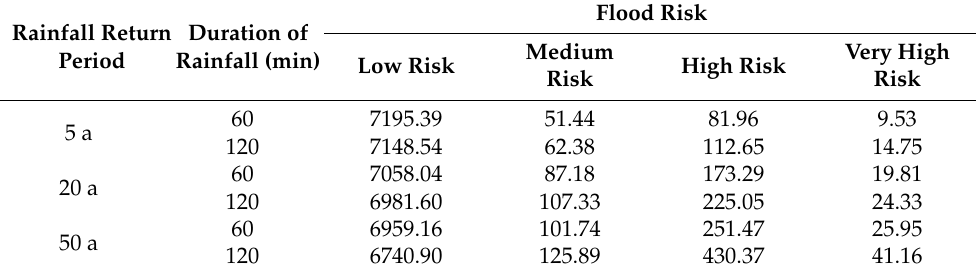
Table 6. Area statistics for inundation flood risk rates for different scenarios